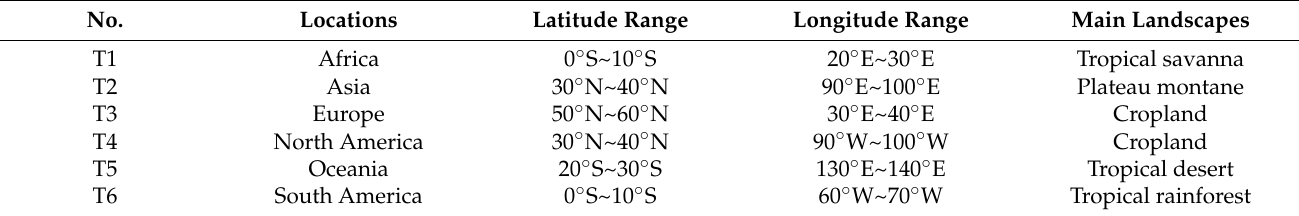
Figure 4. The six true color large-scale images for the distributed image segmentation experiments. Table 1. The metadata of the six composite images.